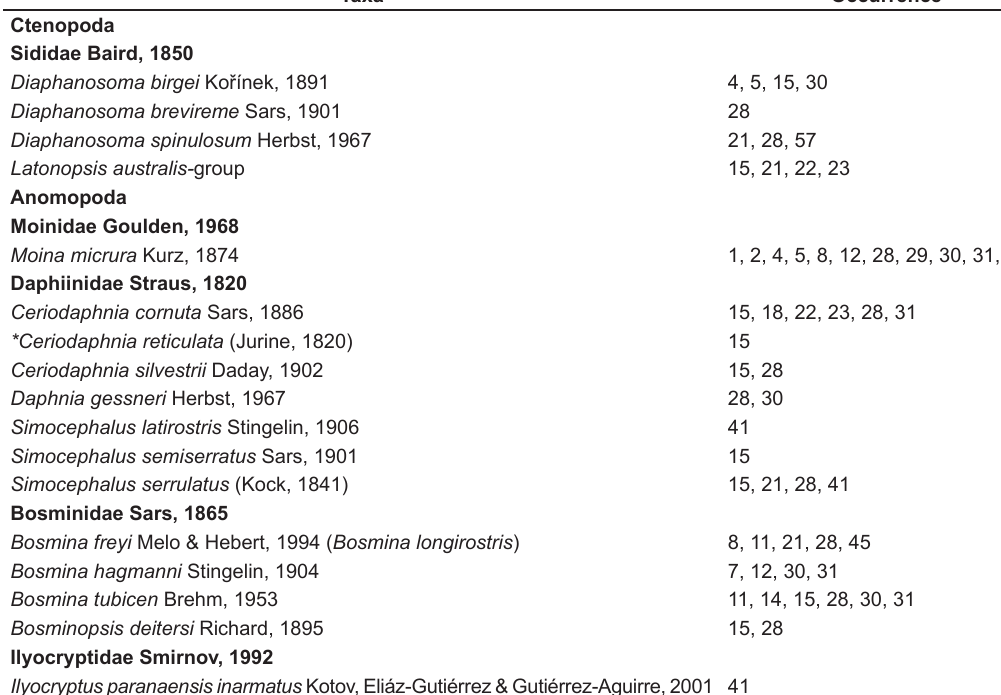
Table 2. Checklist of the cladocerans species from the Federal District with occurrence of each species in water bodies. Taxa